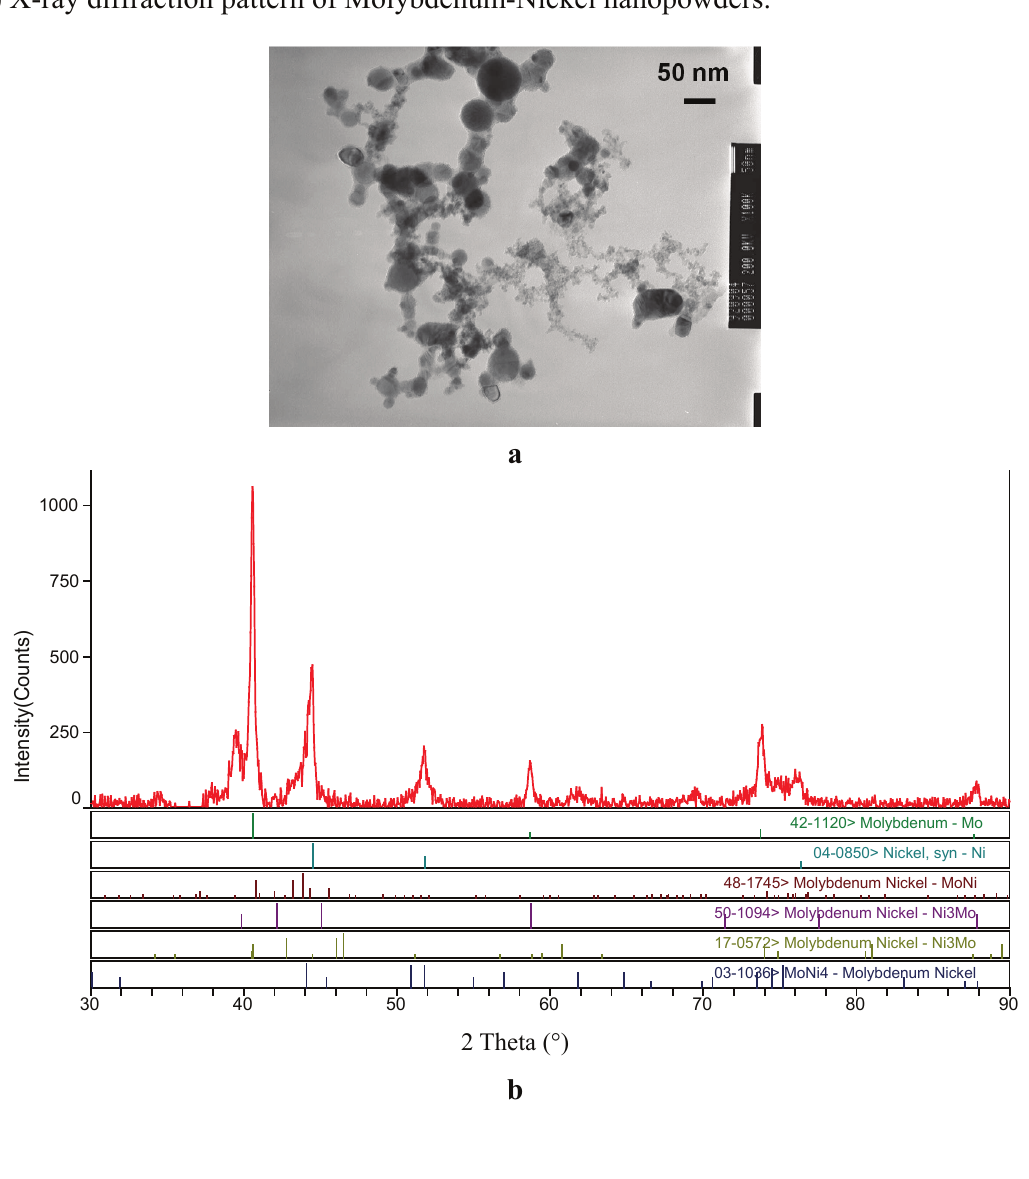
Figure 7. ( a ) Transmission electron micrograph of Molybdenum-Nickel nanopowders; ( b ) X-ray diffraction pattern of Molybdenum-Nickel